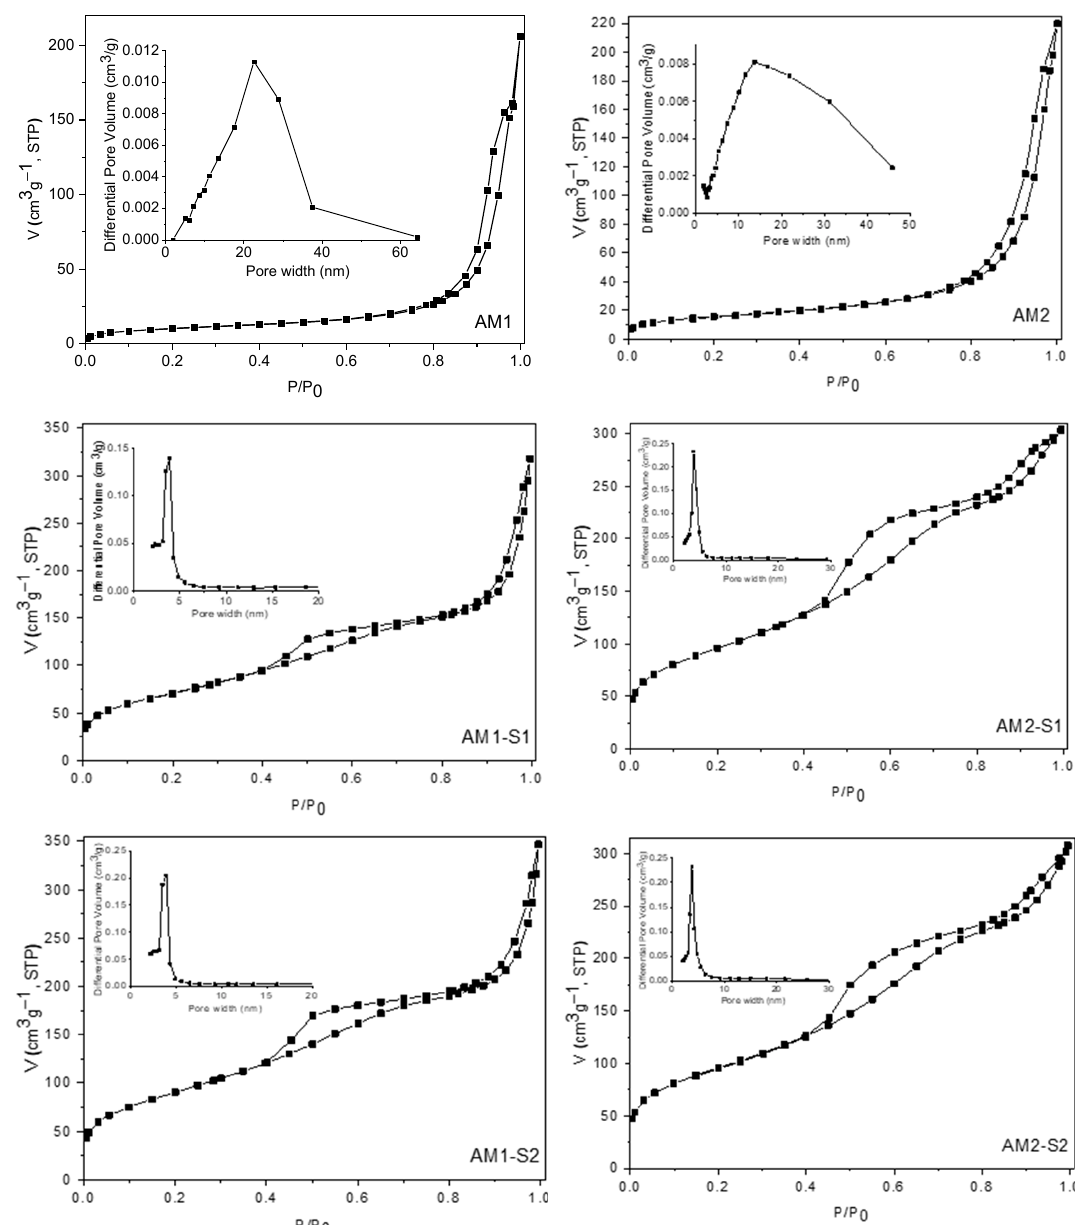
Figure 4. N 2 adsorption–desorption isotherms and pore size distributions (inset of the figures) of the investigated samples.